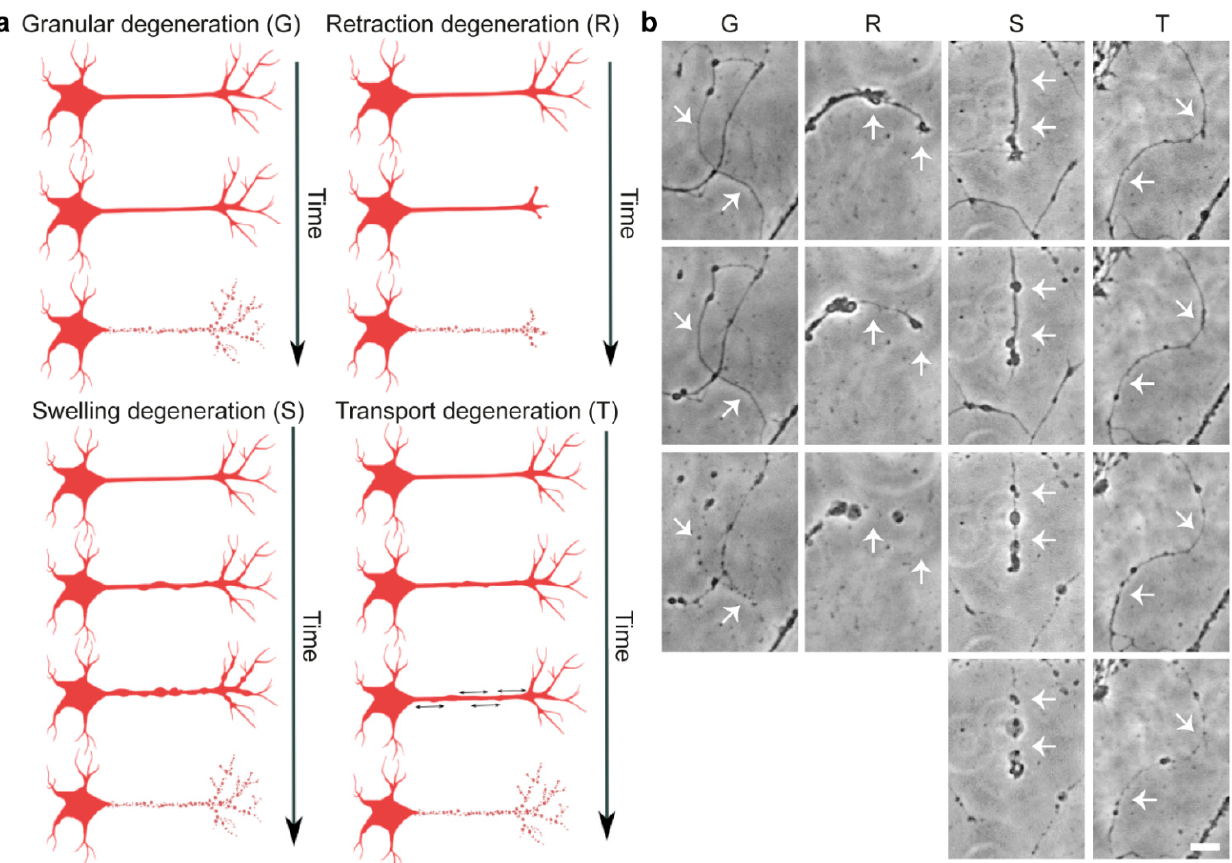
Figure 5. Four morphological patterns of AxD. ( a ) Schematic overview and ( b ) phase-contrast recordings of the proposed AxD morphological patterns in primary cortical axons: Granular degeneration (G) is characterized by the fragmentation of the axon (white arrows). During retraction degeneration (R), the axonal growth cone retracts in the proximal direction, and the part of the axon in proximity of the growth cone disintegrates along with the axonal swellings (white arrows). During swelling degeneration (S), many axonal swellings enlarge, resulting in axonal fragments (white arrows). During transport degeneration (T), the transport of axonal swellings along the axon is halted prior to the degeneration of the axon (white arrows). Scale bar: 20 µm. For complete time-lapse videos including segmentation, refer to Videos S5–S8 .